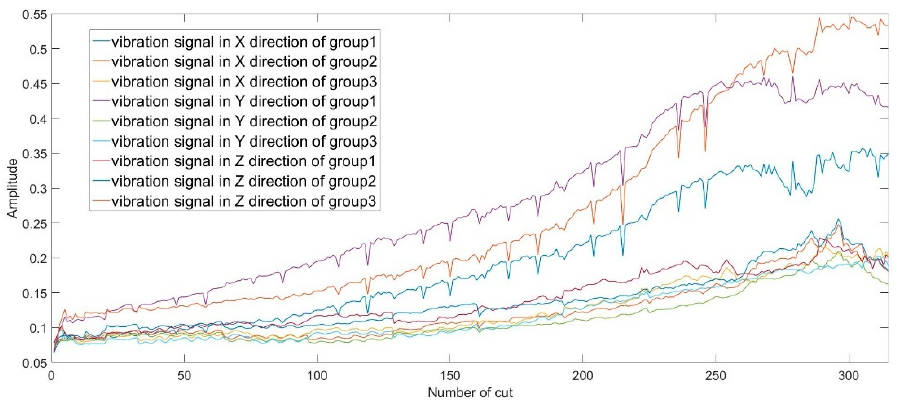
Figure 4. Vibration signals of tool in the milling process.